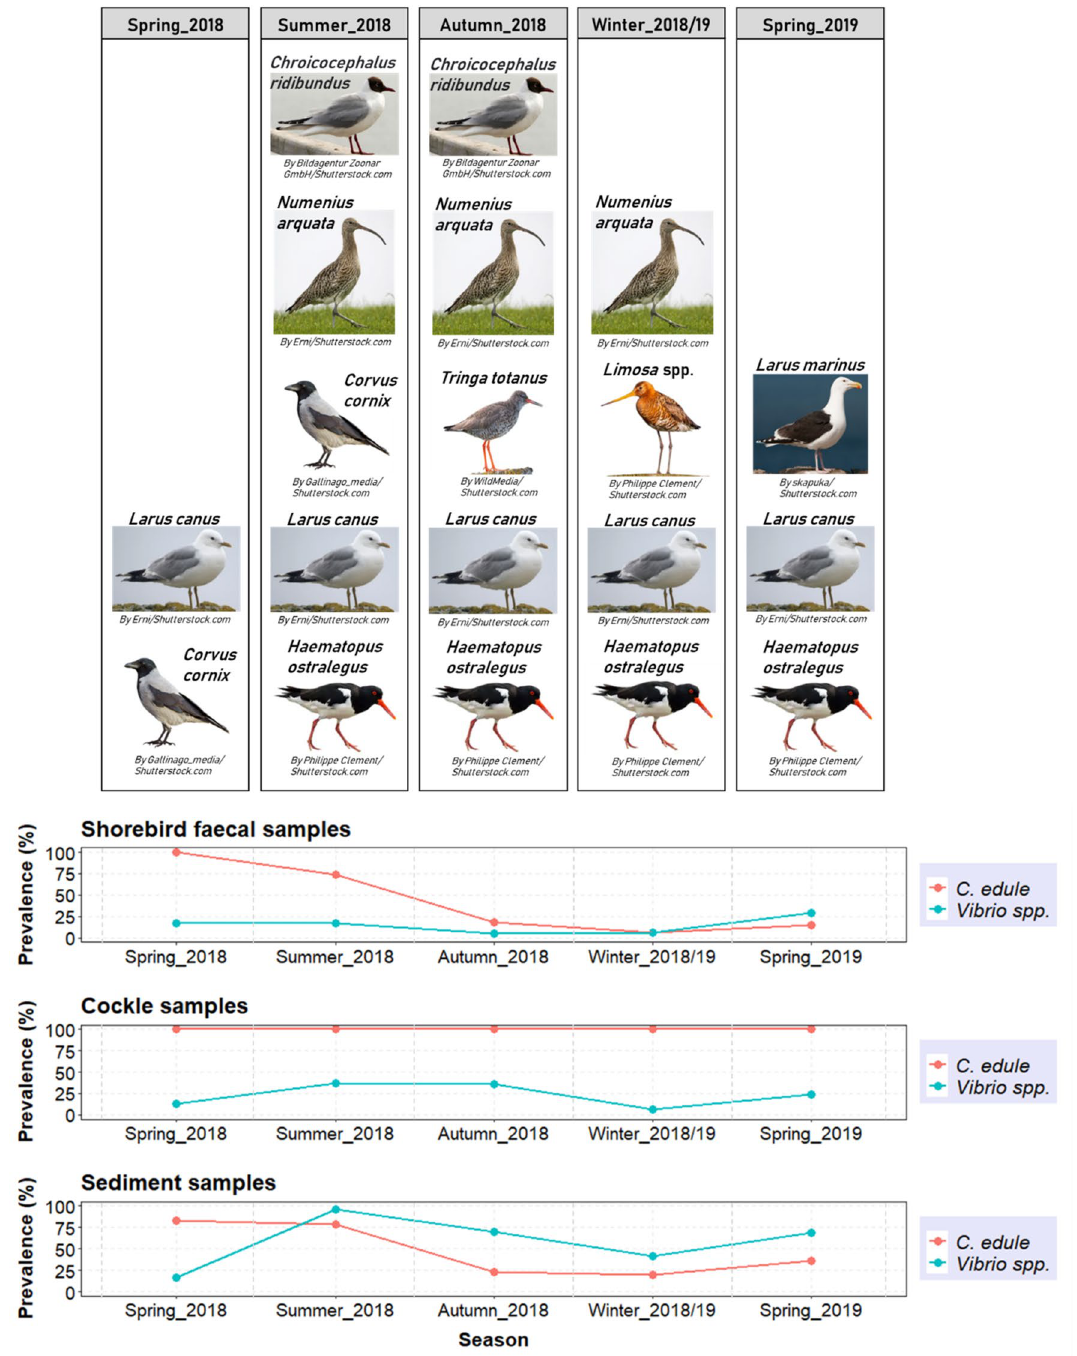
Figure 3. Distribution of C. edule DNA compared to the presence of Vibrio spp. in shorebird faecal samples, cockles, and sediment samples throughout the seasons. The most frequently observed shorebird species through the sites by each season are represented on the top of the figure (Images used under license from Shutterstock. levels of C. edule DNA found in the sites—no significant correlation (p(τ) > 0.05) was established between the presence of C. edule DNA and Vibrio DNA detected within the sediment compartment—(Fig. 2). Significant seasonal variability (p(Chisq) < 0.01) in the occurrence of Vibrio spp. was exhibited in the three studied compartments—sediment, cockles, and shorebirds-. The highest presence of Vibrio spp. in C. edule , bird faecal samples and sediment samples, was during the warmer months and declined during the winter (Fig. 3). The presence of Vibrio spp., therefore, followed the same seasonal trend as the occurrence of C. edule DNA in both faeces and sediment samples (Fig. 3), although the correlation between C. edule DNA and Vibrio DNA detected